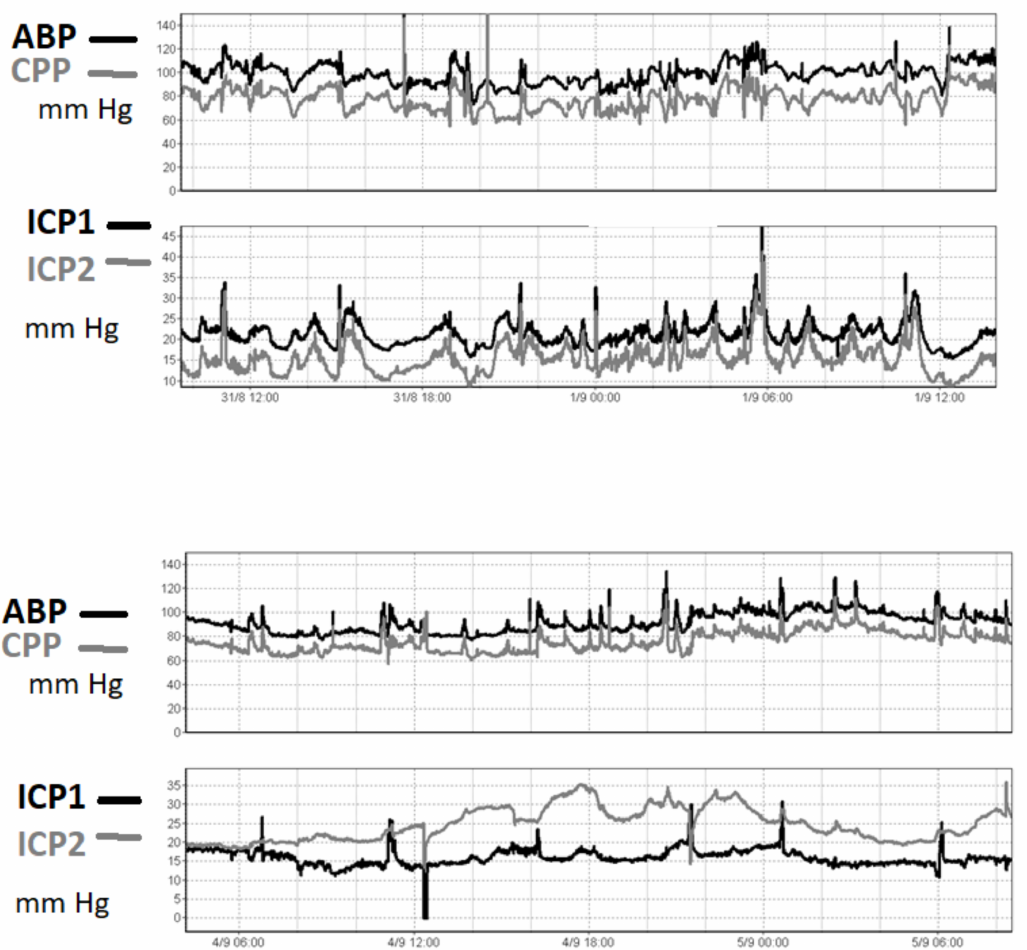
Figure 2. An ICP recording in one patient after TBI. ICP was recorded using two intraparenchymal microsensors (ICP- left hemisphere, ICP2- right hemisphere). In the upper panel, the two pressures are very well correlated in time, even though around 6 mm Hg of constant difference between the two readings is observed. In the lower panel, in contrast, the difference is seen to have increased to 20 mm Hg three days later. This patient suffered from diffuse brain injury without midline shift. The reason for the difference in readings was unknown. The true value of the ICP cannot be determined from these